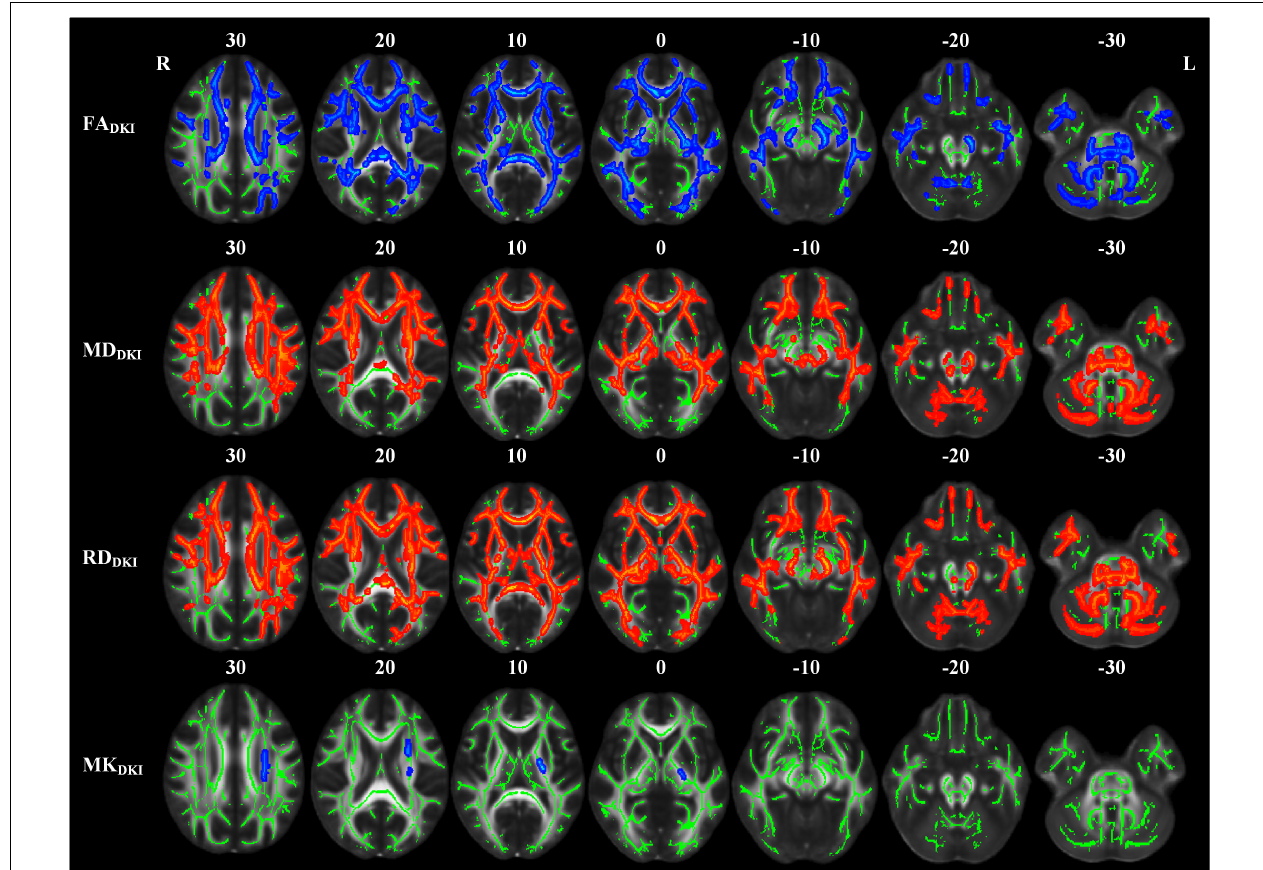
FIGURE 4 | TBSS analyses showed abnormal white matter tracts in the LPI group with DKI-derived parameters. Red indicated white matter tracts with significantly increased parameter values and blue indicated white matter tracts with significantly decreased parameter values. Green represented the mean FA skeleton of all subjects. L and R, left and right; FA, fractional anisotropy; MD, mean diffusivity; RD, radial diffusivity; TBSS, tract-based spatial statistics; DKI, diffusion kurtosis